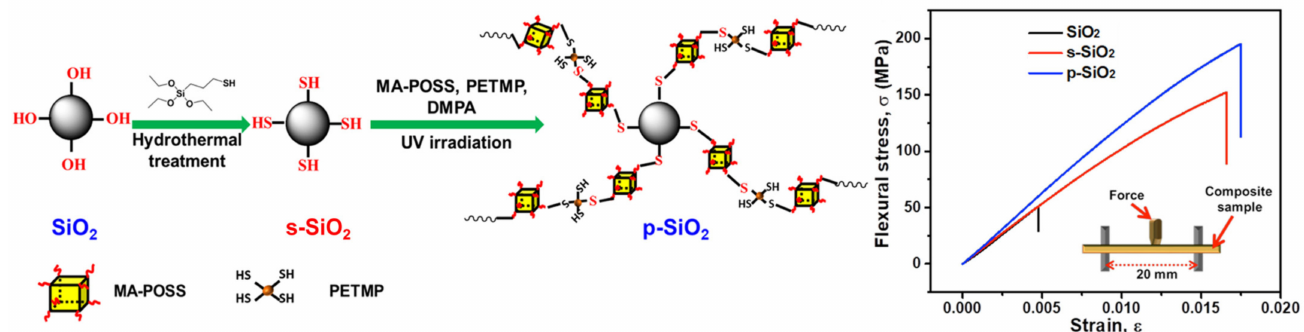
Figure 5. Schematic illustration of the fabrication of hybrid p-SiO 2 particles and stress–strain curves of obtained composites. Reprinted with permission from Chen, H.; Wei, S.; Wang, R.; Zhu, M.